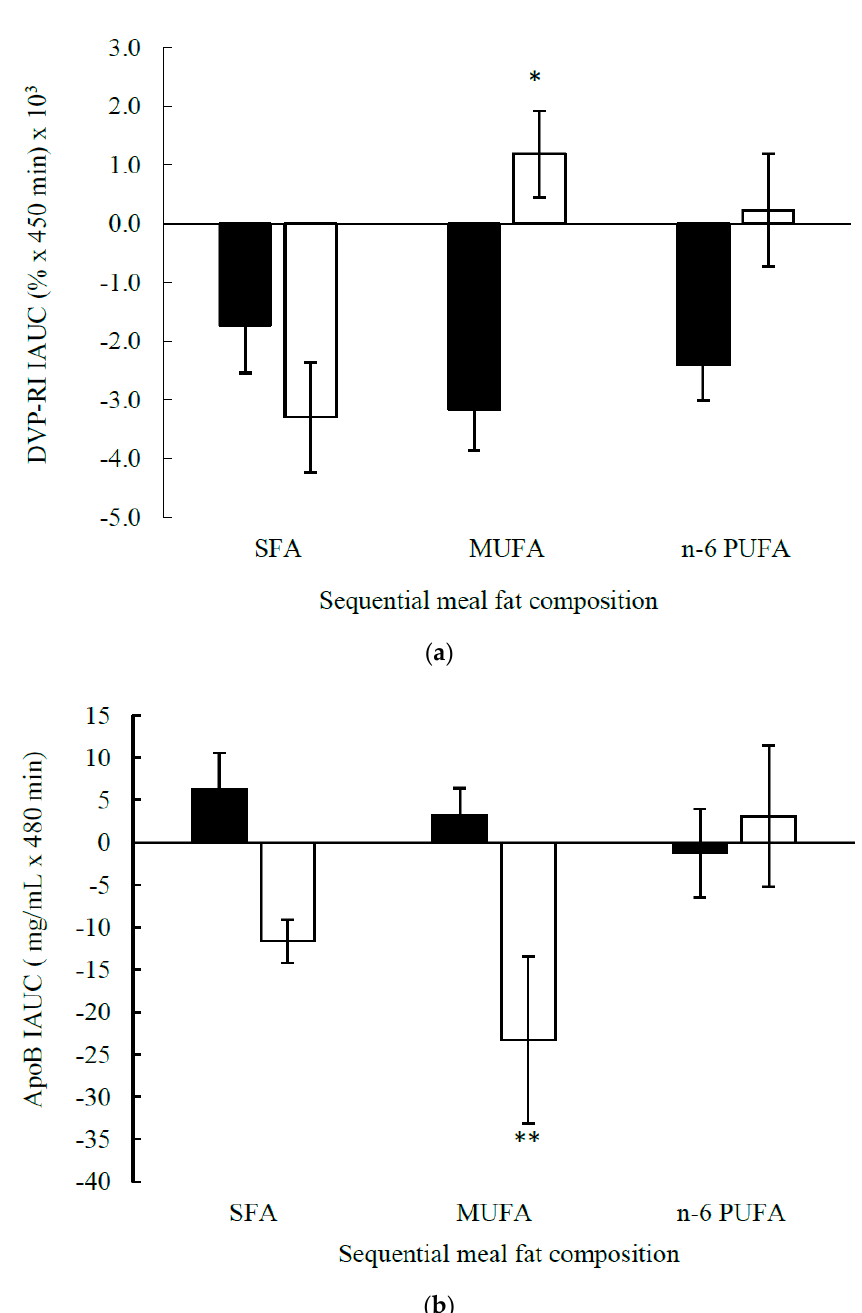
Figure 2. Incremental area under the curve (IAUC) for the postprandial ( a ) digital volume pulse reflection index (DVP-RI) and ( b ) total serum apolipoprotein (apo)B response according to APOE in